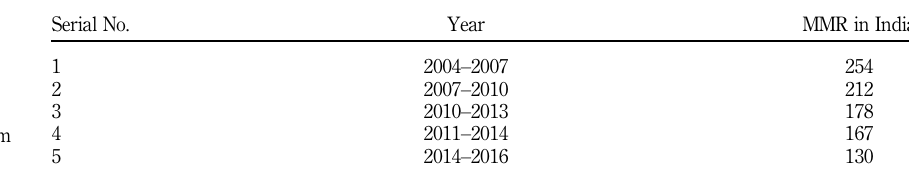
Table II. MMR in India